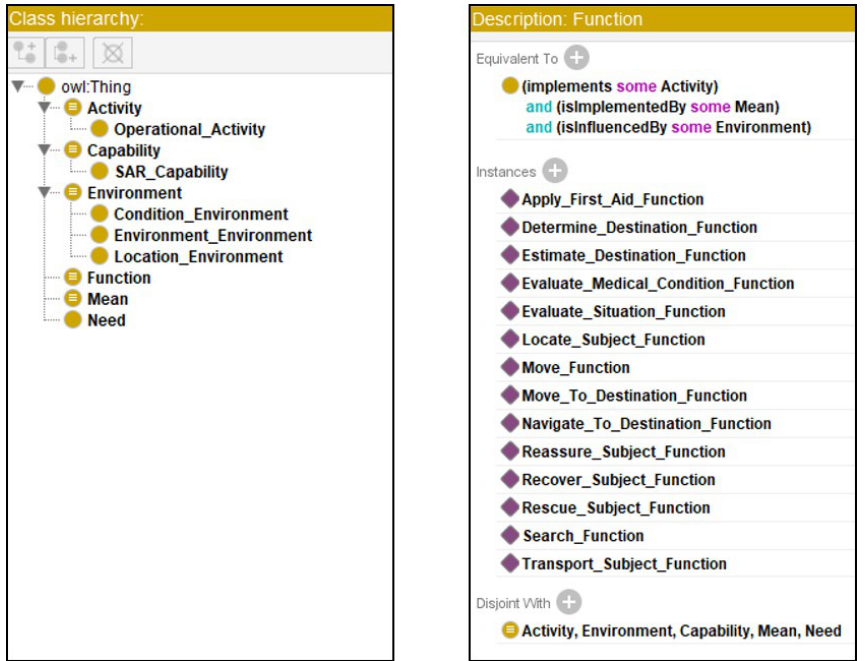
Figure 13. The ontology class hierarchy where the general classes from the UAF breakdown are represented ( left ). The definition of the Function class is shown to the right with its corresponding individuals ( right